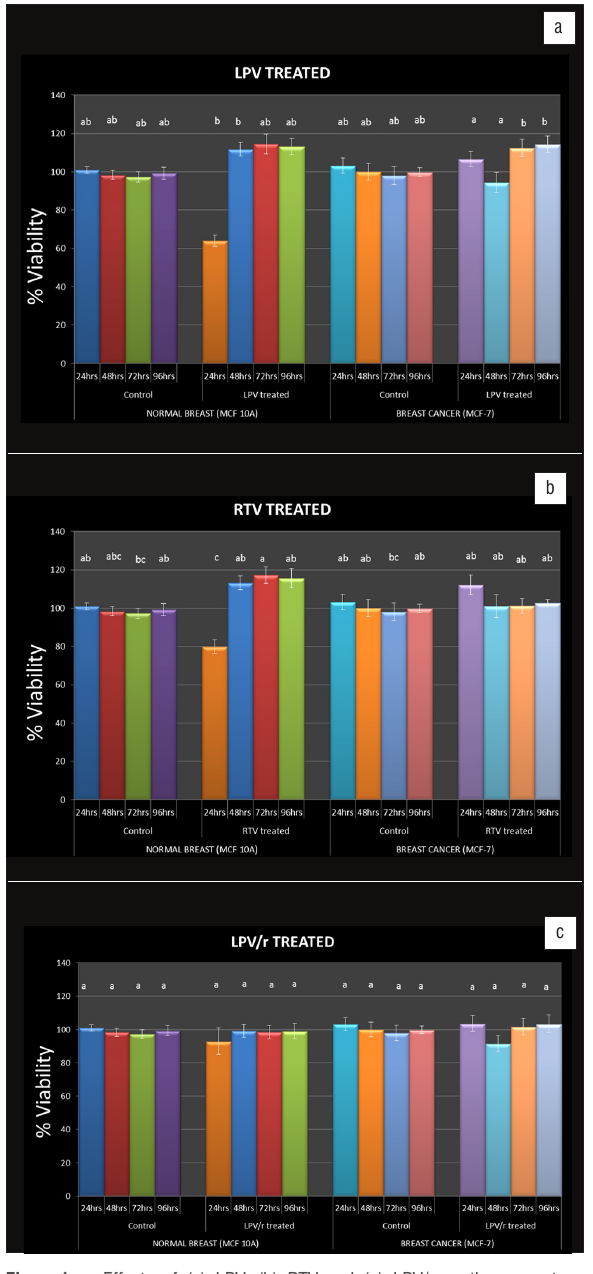
Figure 1: Effects of (a) LPV, (b) RTV and (c) LPV/r on the percentage viability of normal breast (MCF-10A) and breast cancer (MCF- 7) cells. Cells were incubated with 9.8 µg/mL LPV, 0.6 µg/mL RTV and 9.8 µg/mL LPV/0.6 µg/mL for 24–96 h. Graphs were plotted with mean+SEM percentage viability from a mean of three.